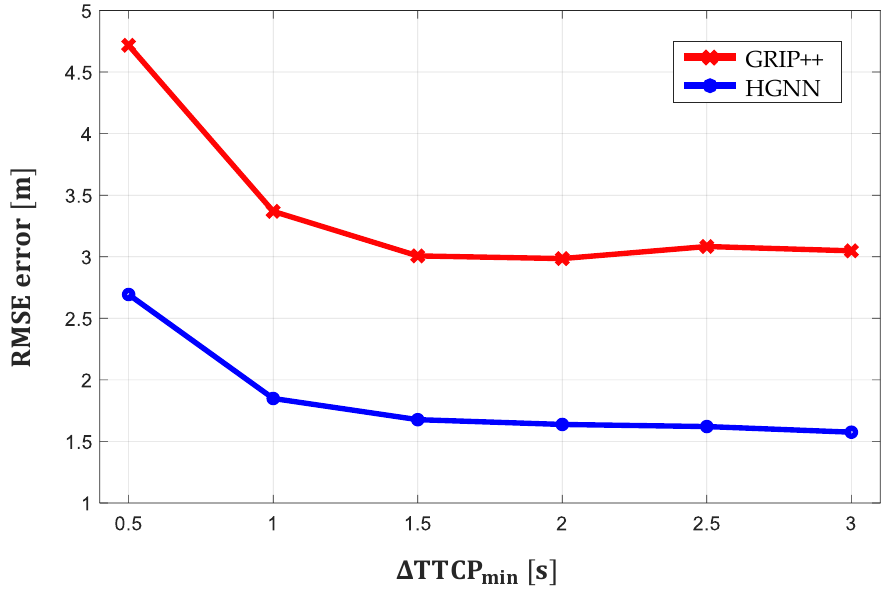
Figure 10. RMSE error at different ∆ TTCP min